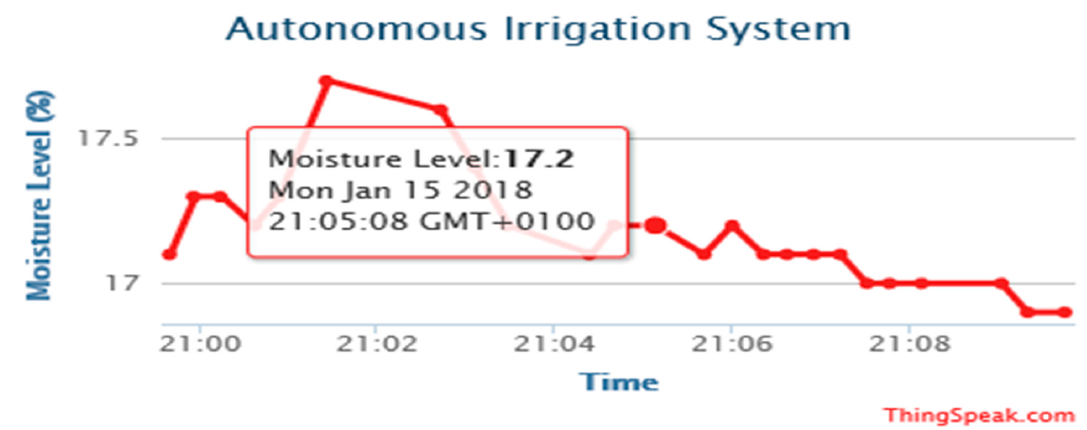
Figure 14. Moisture levels against time obtained from http://www.thingspeak.com (API key =9VHO8NR618JJT9CN).